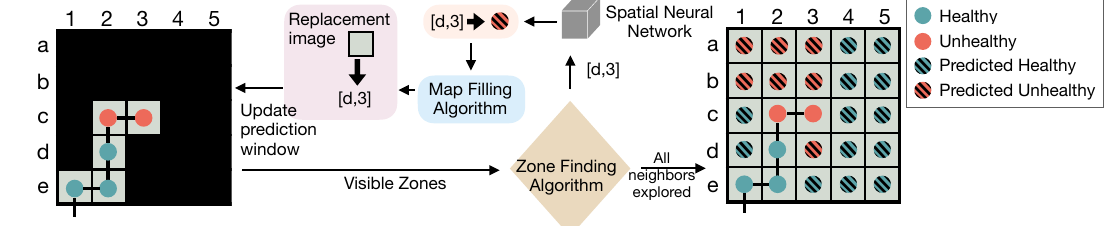
Figure 4. Crop health map prediction algorithm within a prediction